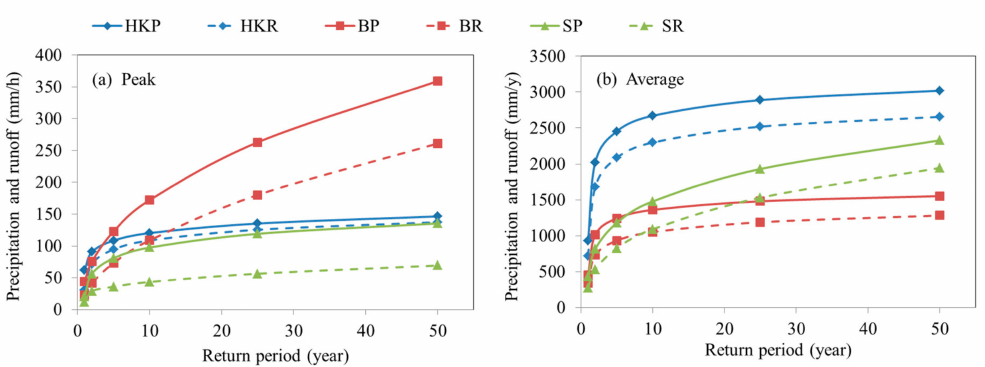
Figure 3. Precipitation (P) and green roof runoff (R) in storms with different return periods. Figure 3( a ) and ( b ) show the peak and average values, respectively. HK, B and S stand for Hong Kong, Beltsville and Sidney,